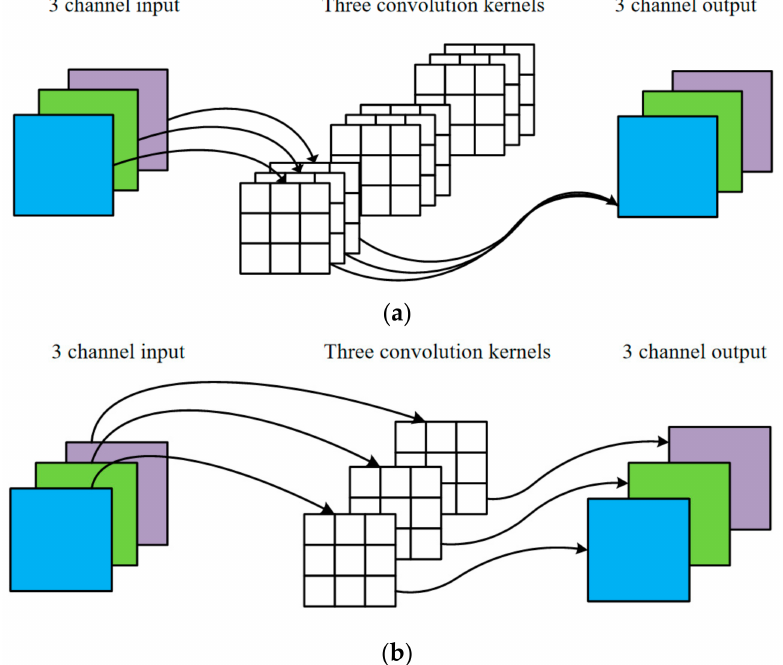
Figure 3. The difference between two convolution operations: ( a ) ordinary convolution operation, ( b ) deep convolution